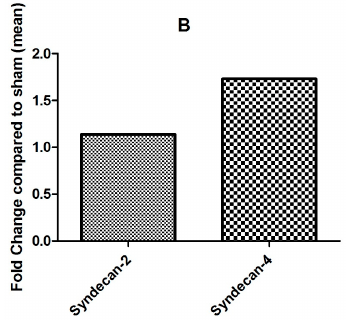
Figure 2. Flow cytometry analyses of endothelial SDC2 and SDC4 expression following TNF α stimulation. Shown are absolute expression values ( A ) and fold changes ( B ) compared to untreated cells for experimental details see Materials and Methods).